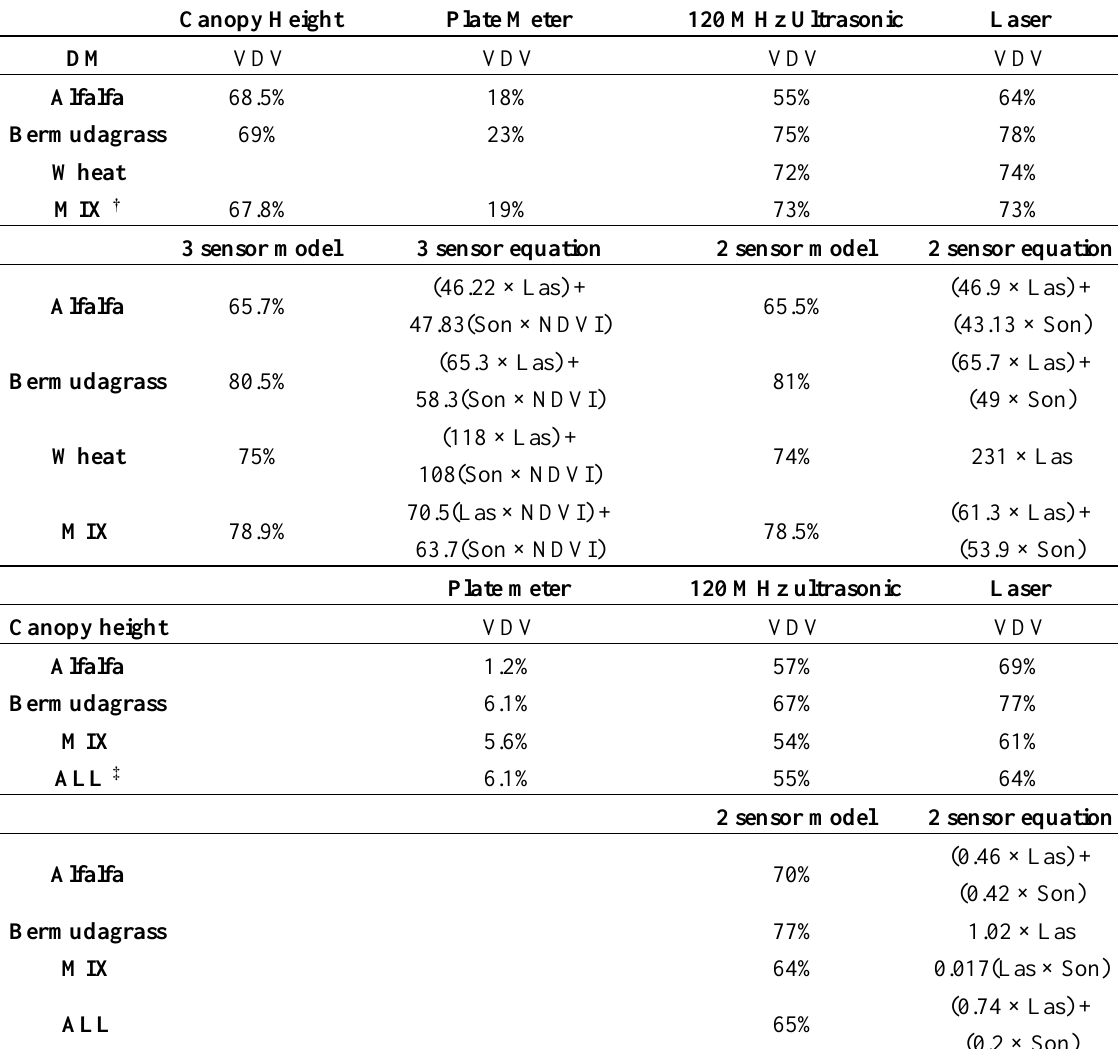
Table 4. Explanation of variation in dependent variable (VDV) from partial least squares regression modeling for dry biomass and canopy height by sensor estimation models and model equations for height (combination ultrasonic and laser model) and biomass (two sensor model: laser and ultrasonic combination, and three sensor model: laser, ultrasonic and NDVI combination). † MIX-Mixture of alfalfa and bermudagrass; ‡ ALL-All monoculture and mixed species from the alfalfa and bermudagrass